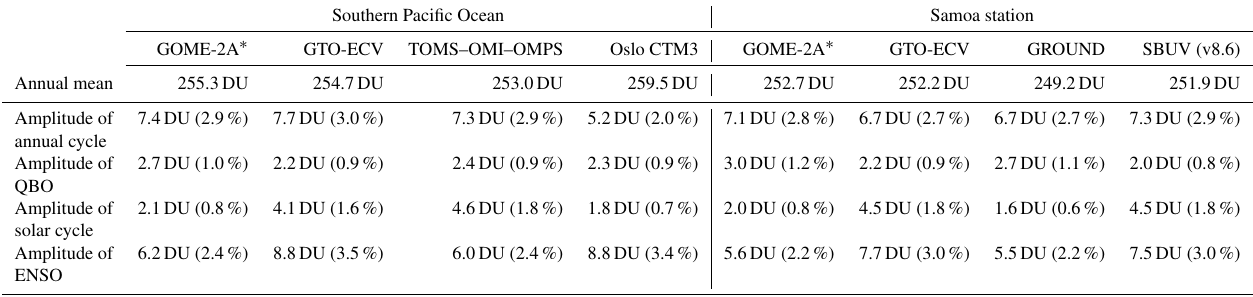
Table 4. Annual mean total ozone, amplitude of annual cycle, amplitude of QBO, amplitude of solar cycle, and amplitude of ENSO in the period 1995–2016 from GOME-2A, GTO-ECV, the combined TOMS–OMI–OMPS satellite data, and Oslo CTM3 model calculations over the southern Pacific region (10–20 ◦ S, 180–220 ◦ E) and at the Samoa station (14.25 ◦ S, 189.4 ◦ E), located within this